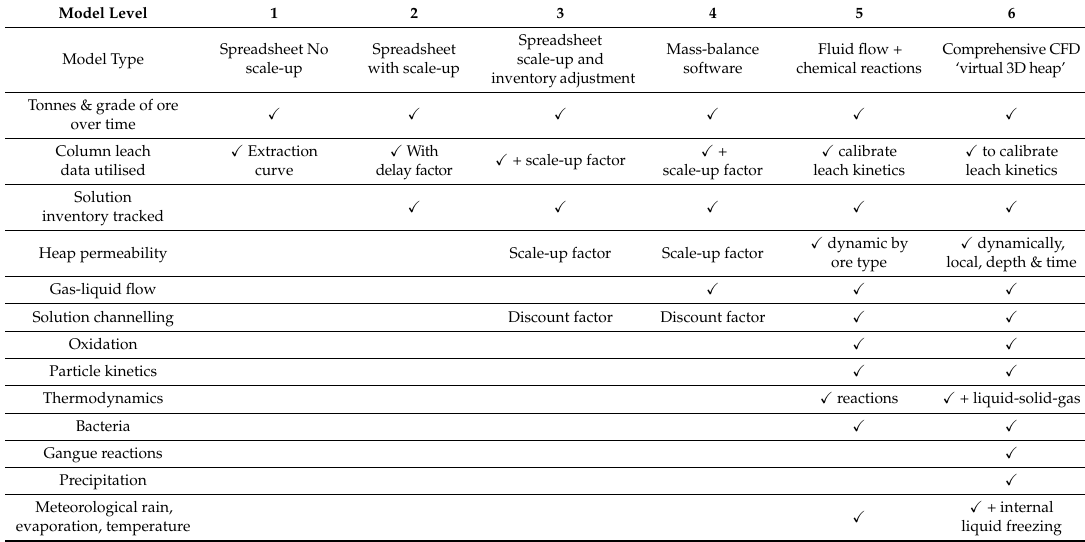
Table 1. Summary of model functionality